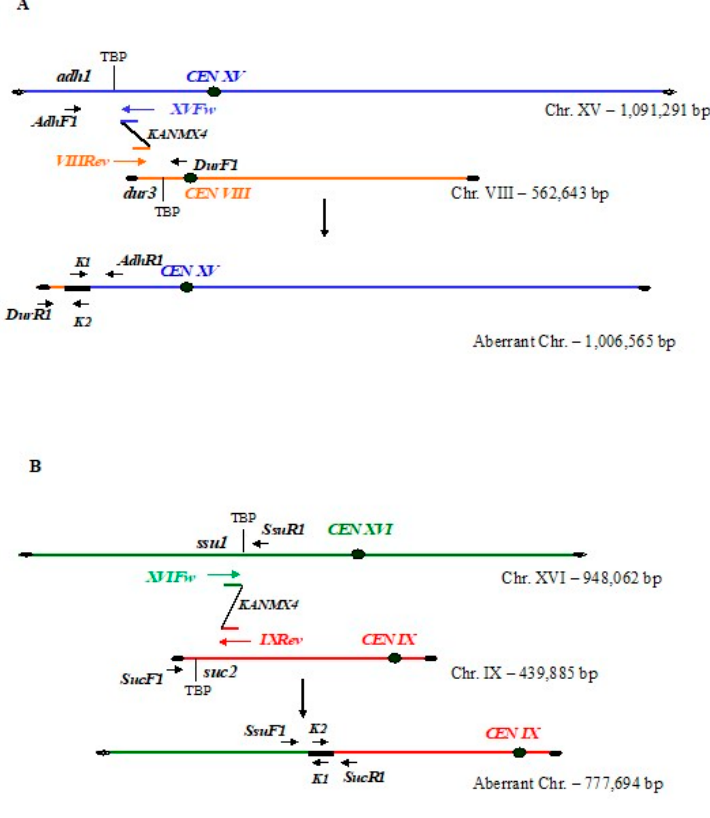
Figure 2. Schematic representation of the two Bridge-Induced Translocation events studied in this work. ( A ) BIT between chromosomes VIII and XV. The amplified selectable DNA cassette has two 65 bp ends homologous to the dur (VIII) and adh (XV) loci. Primers XVFw and VIIIRev, used to amplify the BIT cassette, are indicated with an arrow in blue and orange colors, respectively; primers used to check the integration of the translocated chromosomes (AdhF1, AdhR1, DurF1, DurR1) are reported with an arrow in black along their respective chromosomes. AdhR1 and DurR1 primers were used to amplify the TBP (translocation breakpoint) between the two chromosomes. ( B ) BIT between chromosomes IX and XVI. The amplified selectable DNA cassette has two 65 bp ends homologous to the ssu1 and suc2 loci. Primers XVIF and IXRev used to amplify the BIT cassette are indicated with green and red colors, respectively; primers used to check the integration of the translocated chromosomes (SsuF1, SsuR1, SucF1, SucR1) are reported in black along their respective chromosomes. SsuF1 and SucR1 primers were used to amplify the translocation breakpoint (TBP) between the two chromosomes. CEN: centromere. K1 and K2: primers used to check proper integration. Only the resulting translocant chromosomes without other fragments or secondary rearrangements coming from the two BIT events are reported in this